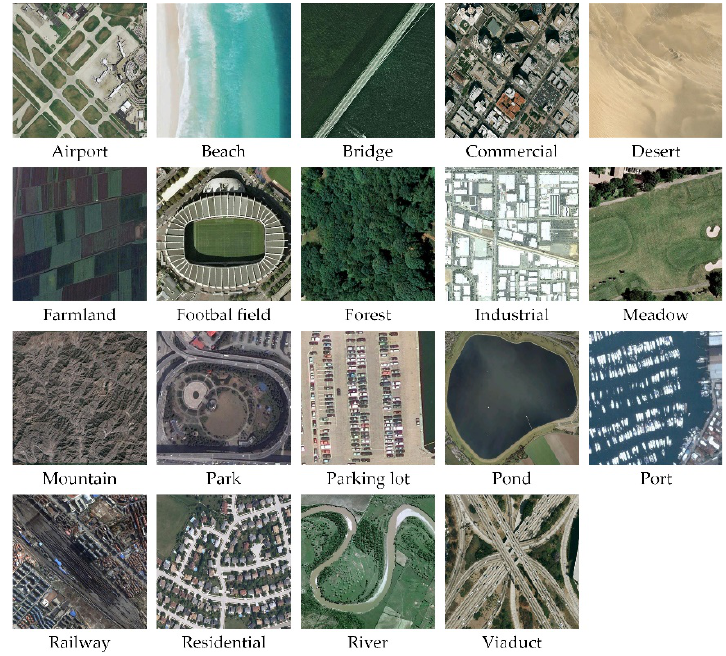
Figure 7. The example ground truth images of each scene category in the WHU-RS dataset.